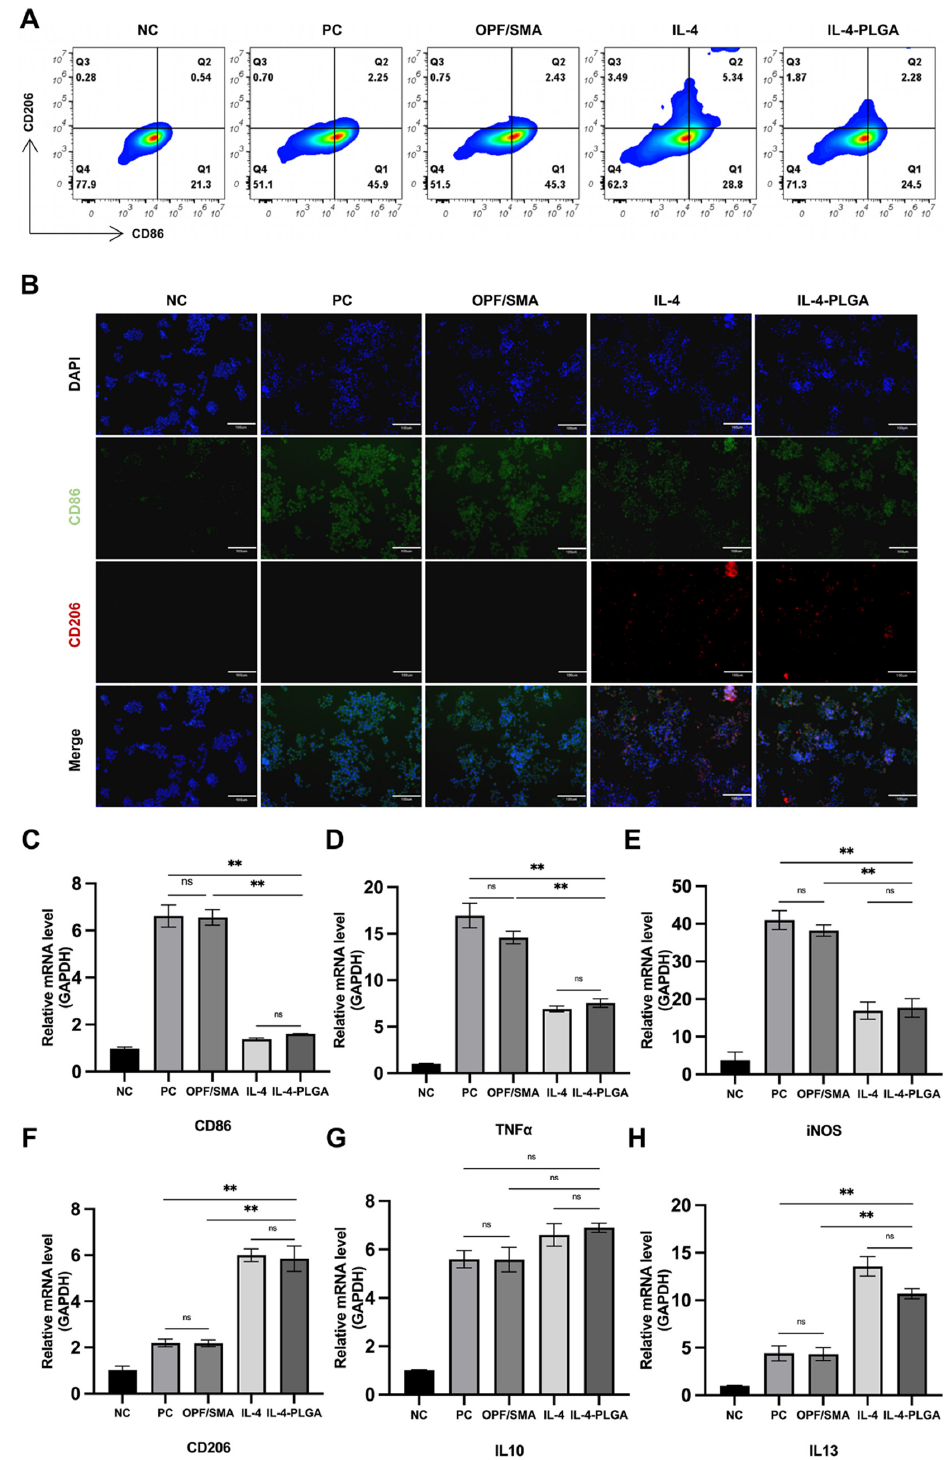
Figure 4. Polarization of macrophages. Raw264.7 macrophages in the control group were treated with lipopolysaccharide (100 ngmL − 1 ) for 6 h and then cultured in complete culture medium. The experimental group was treated with lipopolysaccharide for 6 h and then treated with OPF/SMA-, OPF/SMA+IL4-, and OPF/SMA+IL-4-PLGA-conditioned medium. ( A ) After 24 h, the expression of CD206 and CD86 was detected by flow cytometry. ( B ) Immunofluorescence assay to detect the expression of CD206 and CD86. ( C – H ). Quantitative real-time reverse transcriptase-polymerase chain reaction (qRT-PCR). Statistical significance was calculated by one-way ANOVA. ** p < 0.01, ns >